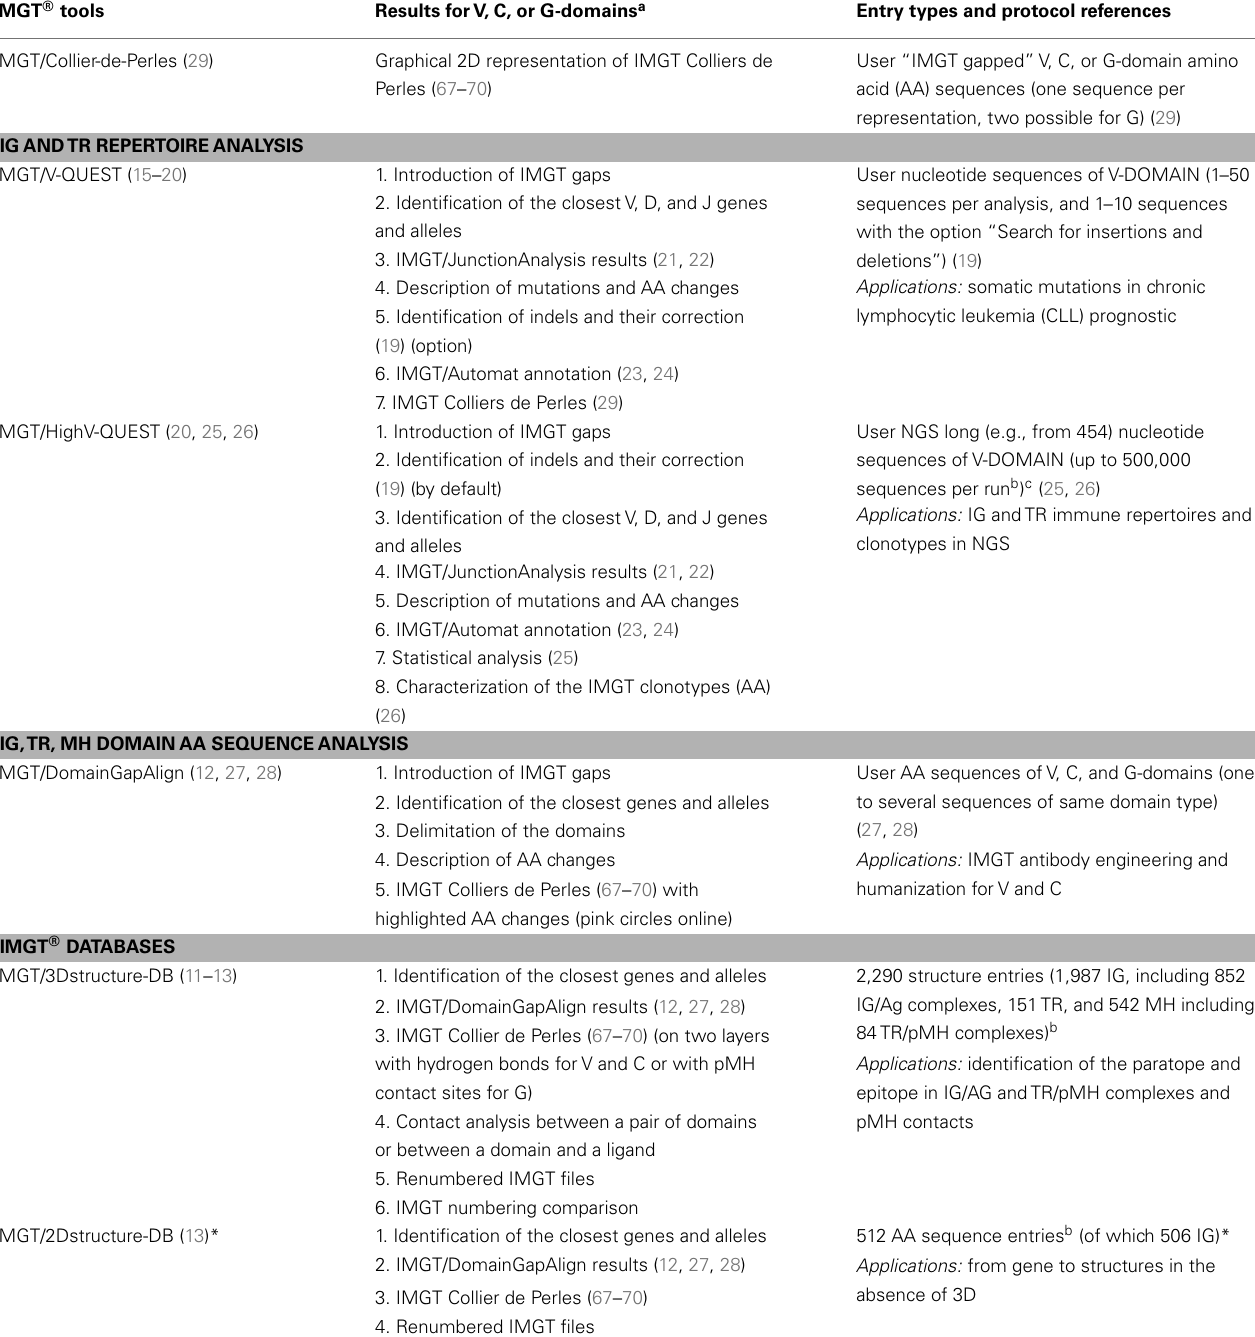
Table 8 | IMGT ® tools and databases for the analysis of the IG,TR, and MH domains (http://www.imgt.org) . IMGT ®